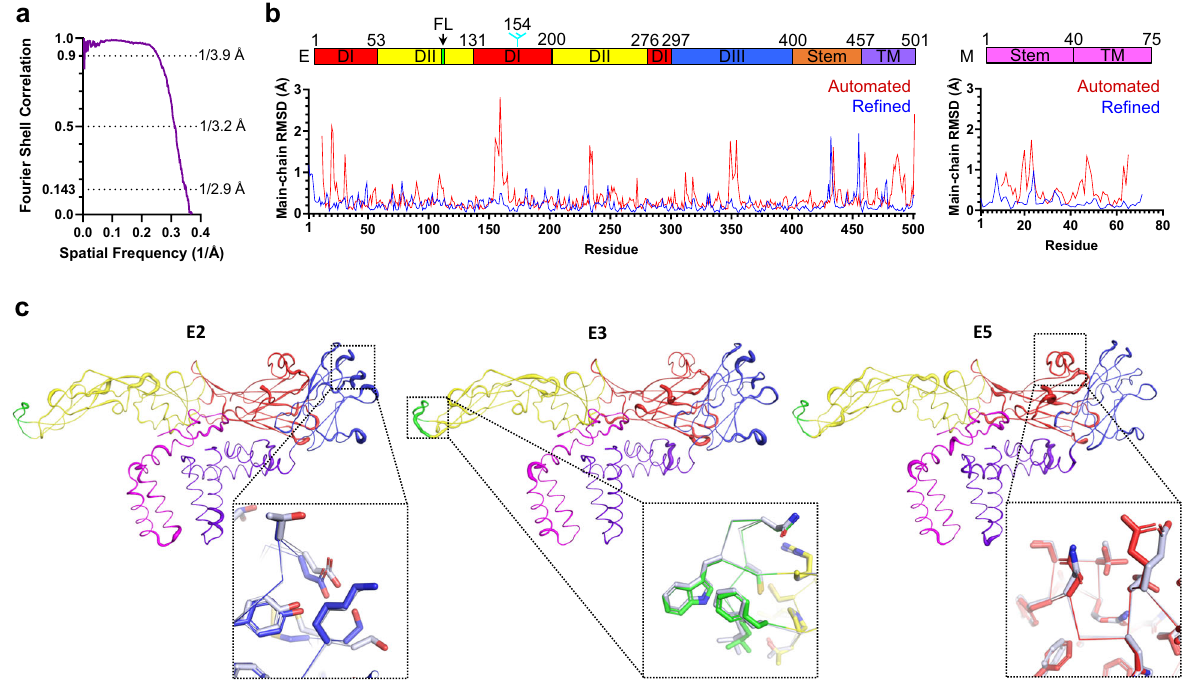
Fig. 3 Chimeric bWNV KUN recapitulates the structure of wild-type WNV KUN . a FSC of the masked maps of bWNV KUN and WNV KUN . b Plot of the root- mean-squared deviation (RMSD) between pairs of main-chain atoms for equivalent residues of the automated build of bWNV KUN and WNV KUN (red), and the best re fi ned models (blue). The corresponding domain organization of WNV KUN is shown as in Fig. 2e. c A ribbon representation of the three copies of E within the asymmetric unit of bWNV KUN coloured as in b . The ribbon thickness is proportional to the local RMSD differences between bWNV KUN and WNV KUN including all equivalent atoms. Differences are very small with an RMSD per residue range of 0.02 – 1.36 Å and an average of 0.41 Å, and primarily located in exposed loops. Selected zoom panels show a close agreement even in regions of maximal RMSD. Side chains are shown as sticks for bWNV KUN (same colouring as ribbon) and WNV KUN